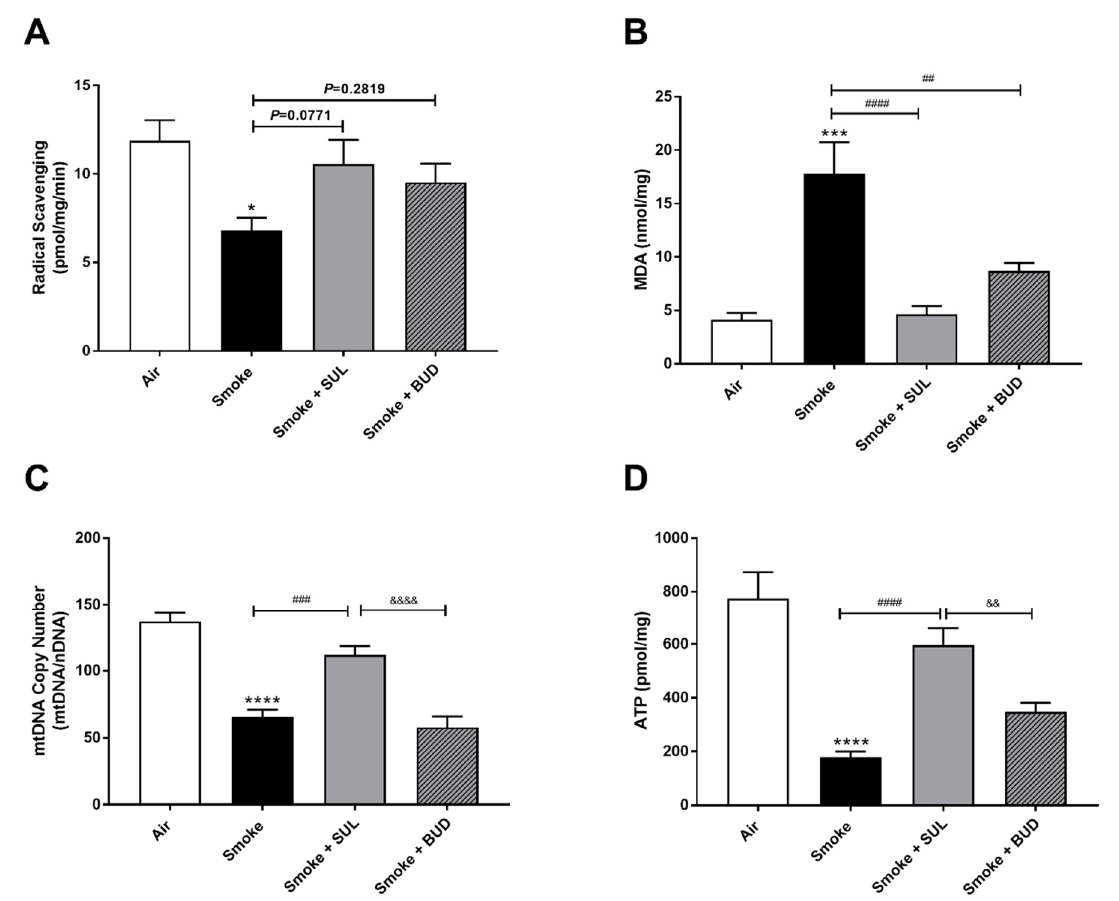
Figure 3. Prophylactic SUL-151 administration prevents oxidative stress in the lungs of a CS exposure model. Mice were exposed to CS for 5 days (twice/day) and received SUL-151 or budesonide via oropharyngeal administration 30 min before the first-time smoke exposure during these 5 days. On day 6, lung tissue was collected, and the radical scavenging activity ( A ), MDA concentration ( B ), mtDNA copy numbers ( C ), and ATP levels ( D ) were measured. Values are expressed as mean ± SEM. * p < 0.05, *** p < 0.001, **** p < 0.0001, smoke group compared to air group; ## p < 0.01, ### p < 0.001, #### p < 0.0001, smoke + SUL group or smoke + budesonide (BUD) group compared to smoke group; && p < 0.01, &&&& p < 0.0001, smoke + BUD group compared to the smoke + SUL group. n = 4–8 mice/group.